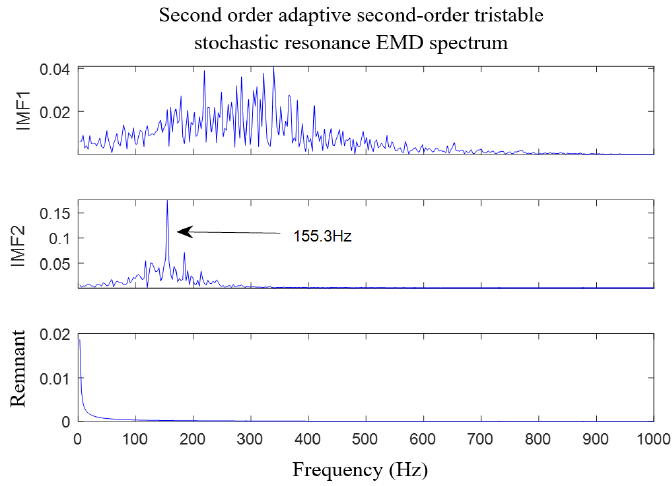
Figure 21. The processing results of the second cascaded stochastic resonance.